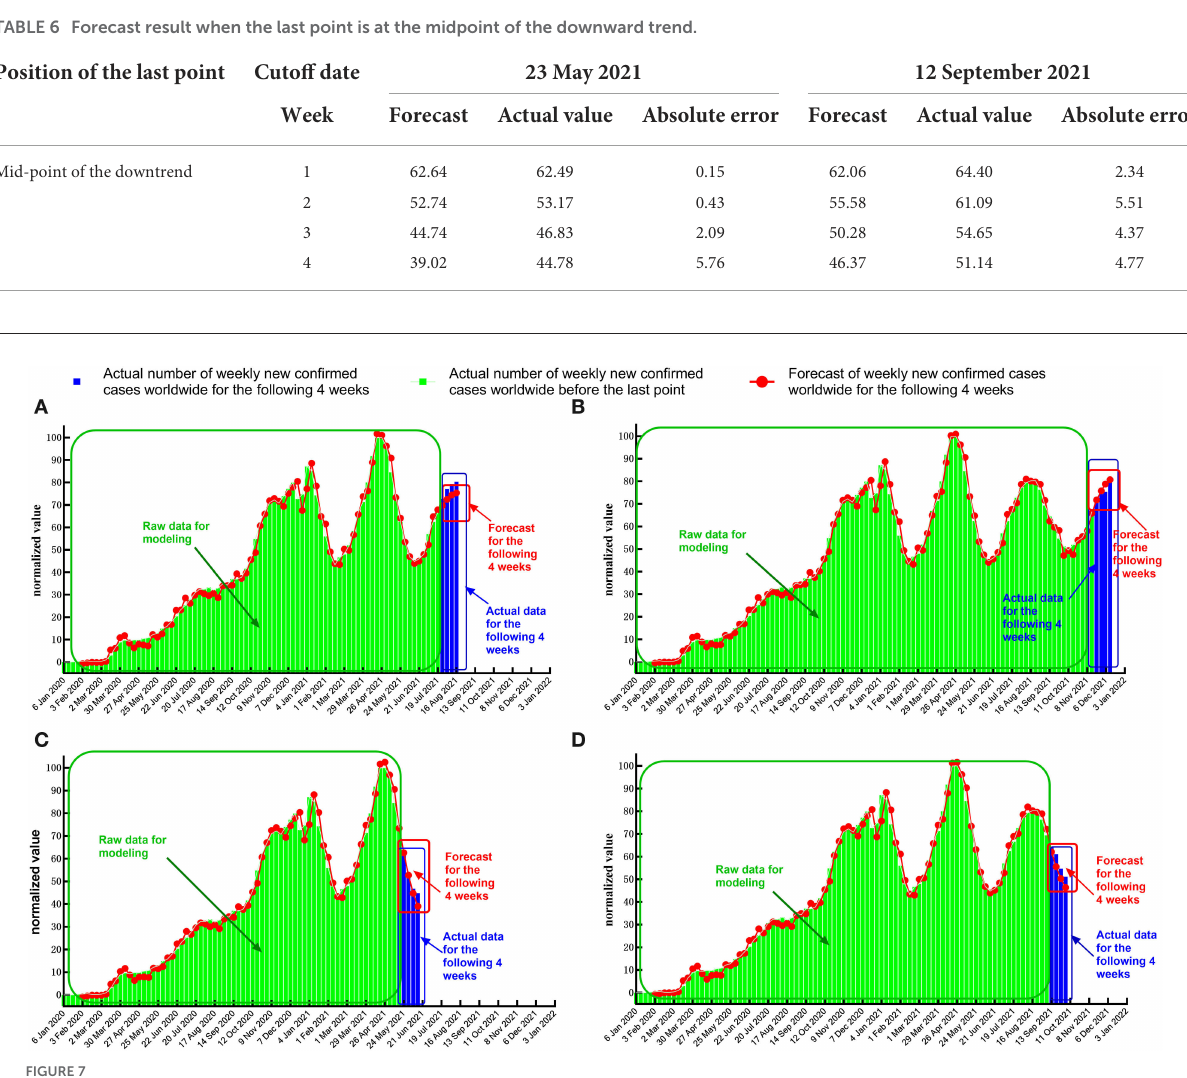
FIGURE7 Timing diagram of forecasts and actual values when the last point of the response sequence is at the midpoint of the upward trend or downtrend. (A) Date of the last point: 25 July 2021 (upward trend 1). (B) Date of the last point: 21 November 2021 (upward trend 2). (C) Date of the last point: 23 May 2021 (downtrend 1). (D) Date of the last point: 12 September 2021 (downtrend